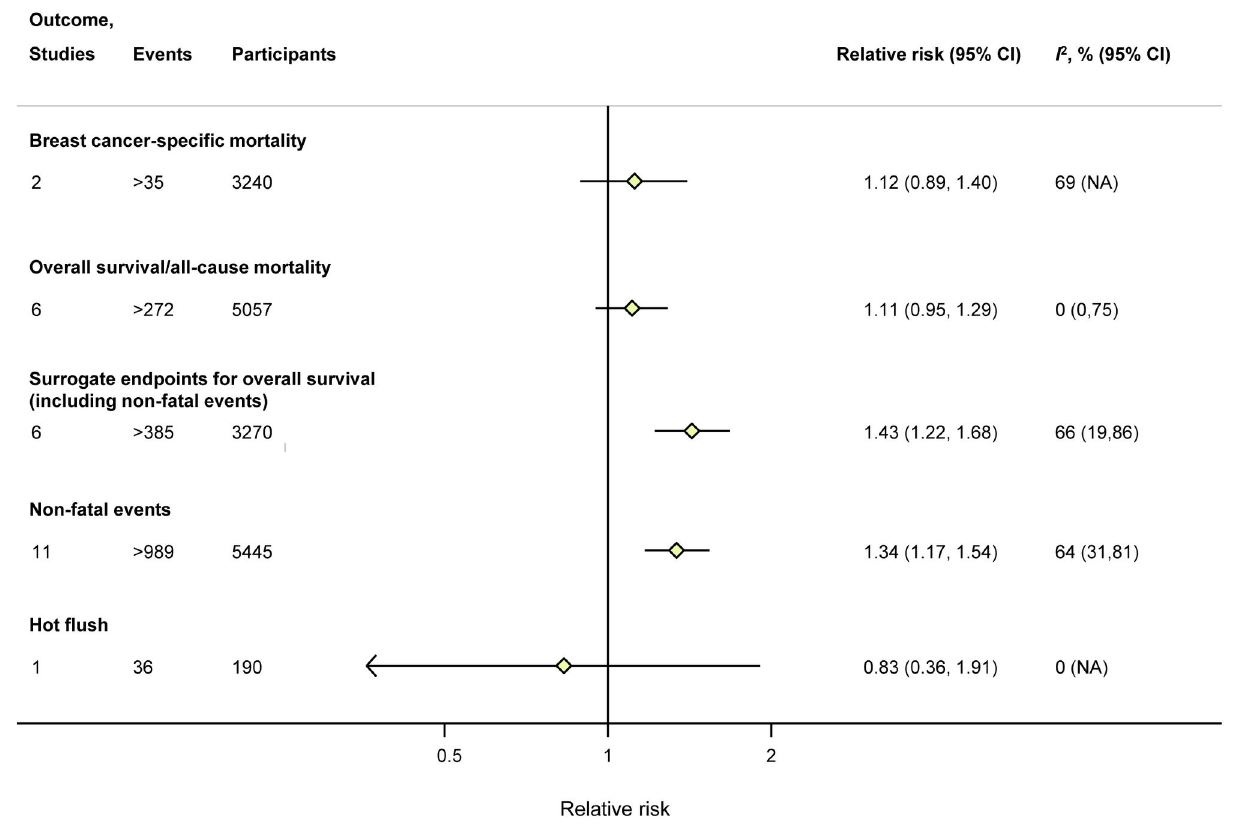
Figure 2. Meta-analysis pooled estimates from treatment-only analysis of the association of any CYP2D6 reduced function alleles vs. none with individual outcomes. Footnotes : Non-fatal events included breast cancer outcomes that were not fatal. doi: